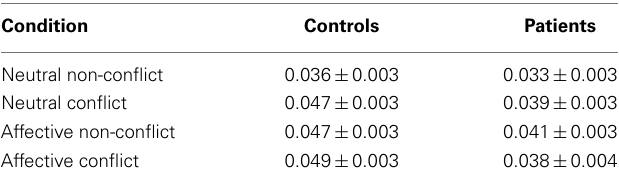
Table 3 | Mean beta estimates of the magnitude of activation ± the standard error of the mean for each condition for patients and controls.